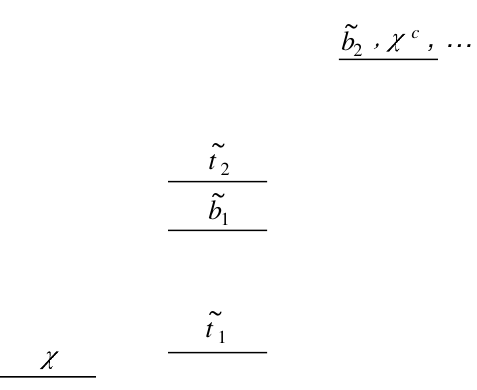
Figure 1 . Spectrum of SUSY partners of the stop-bino coannihilation